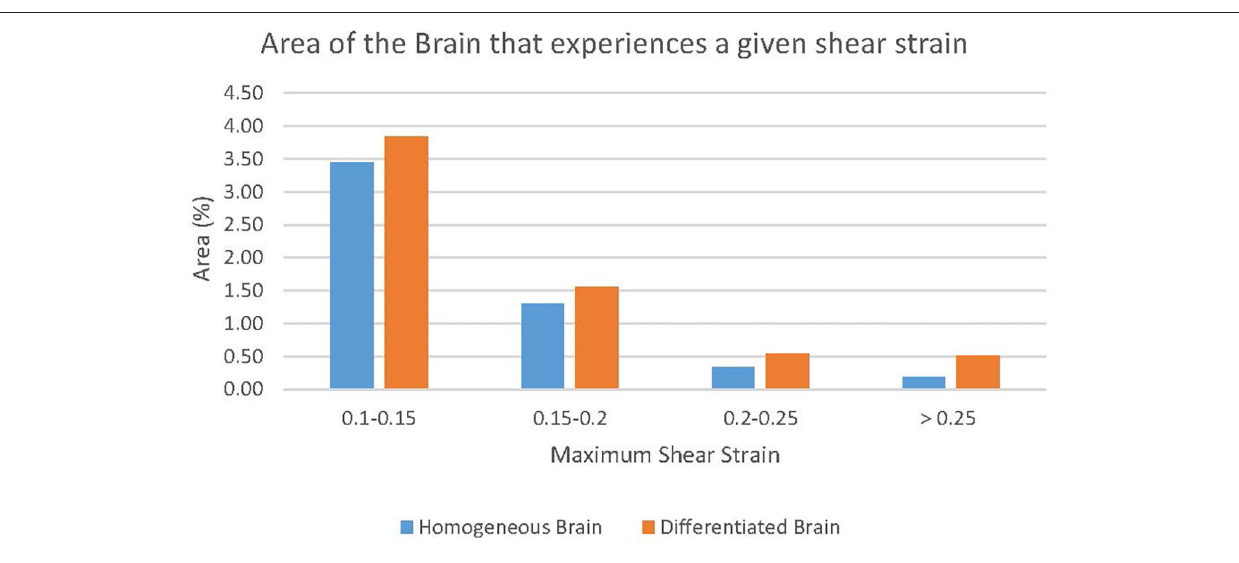
FIGURE 11 | The effect of white and gray matter differentiation on maximum shear strain. The regions of the brains that exceed the highest threshold can be seen in Figure 12